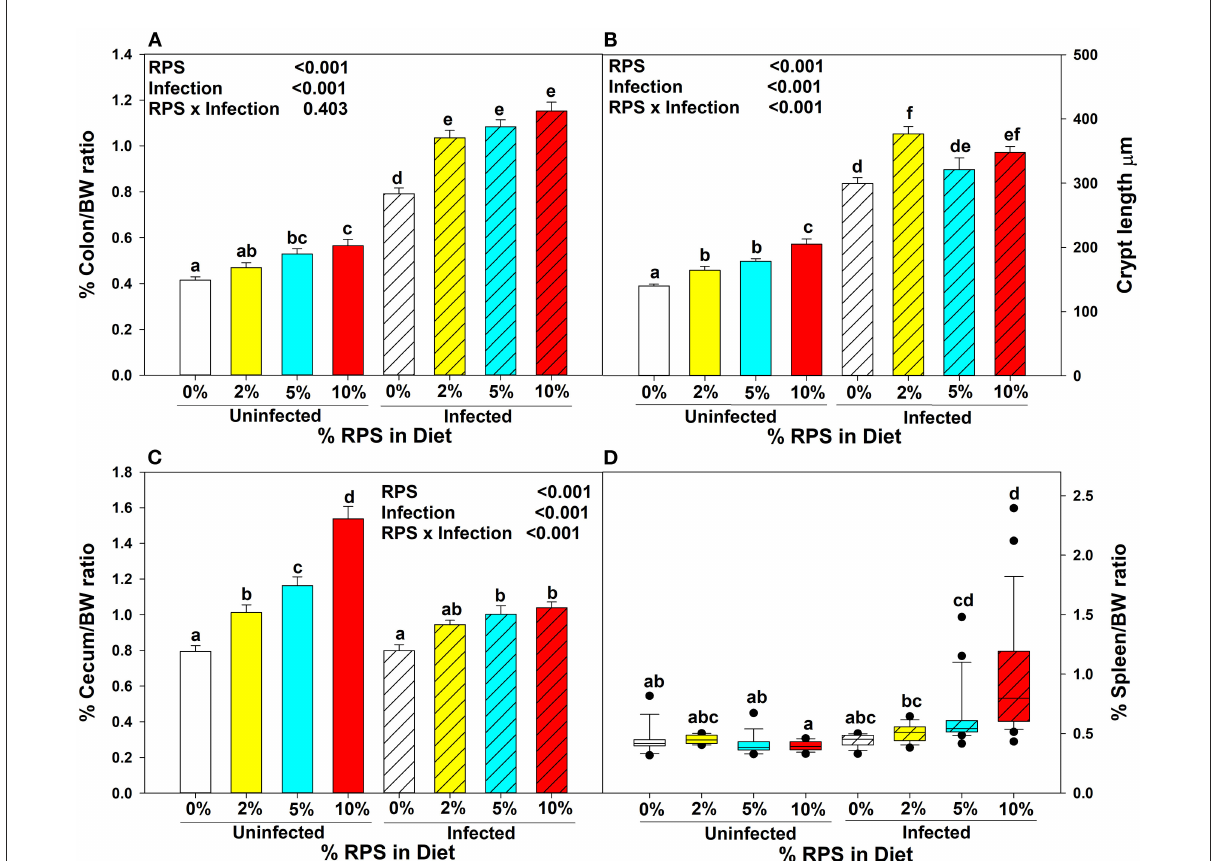
FIGURE1 Dietary RPS and Cr infection alter tissue/body weight ratios and crypt length. Mice were fed the TWD for 6 weeks and then switched to RPS containing diets for an additional 3 weeks. A subset of mice were infected with Cr and euthanized 12 days post-infection. The effect of feeding RPS and Cr infection on %Tissue/bodyweight ratios were calculated for (A) colon, (C) cecum and (D) spleen. Data is from four independent experiments combined, bars are mean ± SEM, n = 14-26/group. (B) The crypt length of uninfected and infected mice fed the different levels of RPS were measured on well-oriented crypts. Data from two independent experiments was combined, n = 5–10, bars are mean ± SEM. Data in (A–C) were analyzed by two-way ANOVA followed by multiple comparisons using the Holm-Sidak method. Data in (D) were analyzed by a one-way ANOVA on ranks followed by multiple comparisons using Dunn’s Method. In all panels, bars with different letters are significantly different p <